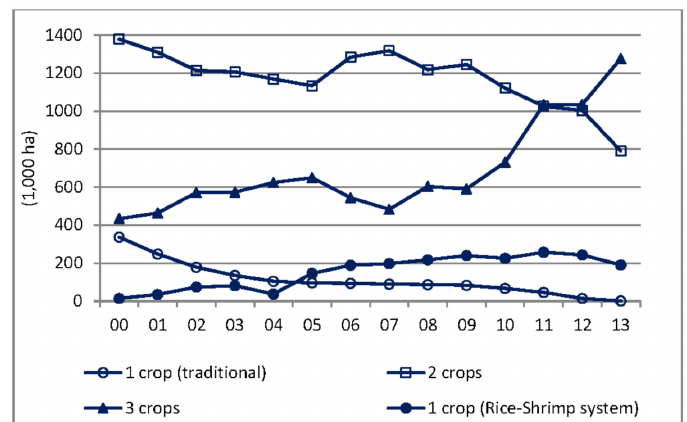
Figure 5. Rice cropping patterns change from 2000 to 2013. Source: The Climate Change A ff ecting Land use in the Mekong Delta: Adaption of Rice-based Cropping Systems (CLUES) project; this figure was not published, related data are available at [26].